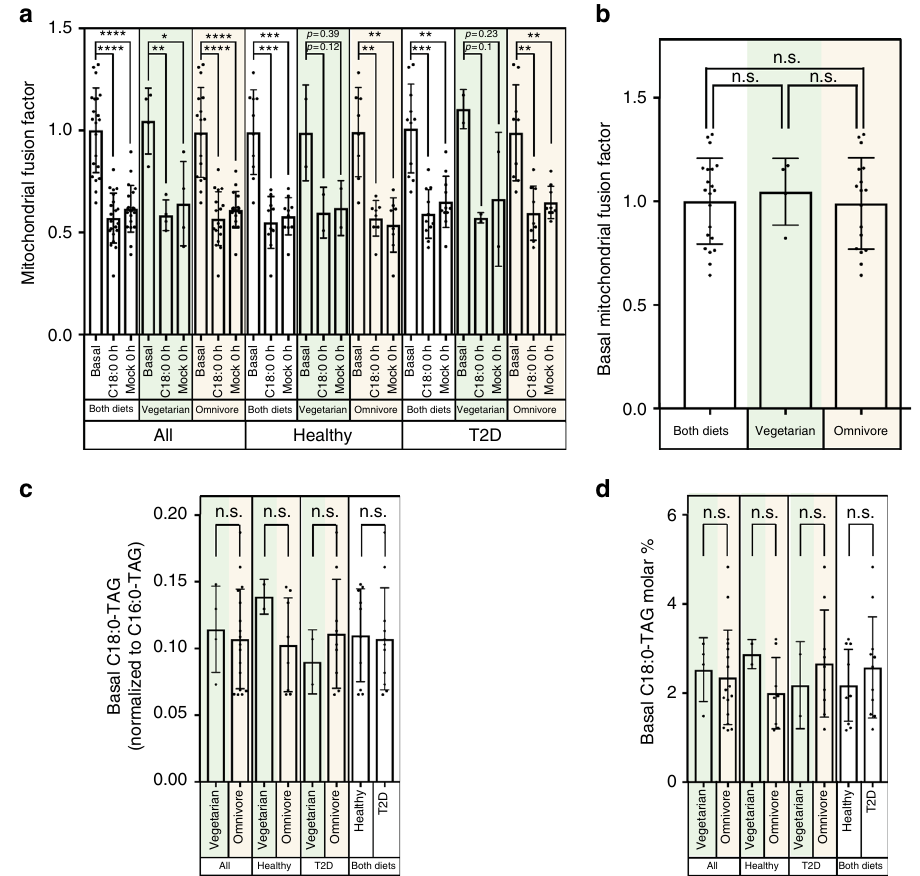
Fig. 4 Mitochondrial morphology is affected by short and medium-term, but not long-term, differences in dietary C18:0 intake. a Mitochondrial fusion drops after a 2-day low-C18:0 vegan diet in all categories of subjects (vegetarian, non-vegetarian, diabetic, healthy). b Basal mitochondrial fusion is similar in vegetarians and omnivores. ( n = 21 subjects total, of which eight healthy omnivores, two healthy vegetarians, nine type-2 diabetic omnivores, two type-2 diabetic vegetarians. Error bars = std. dev. * p ≤ 0.05, ** p < 0.01, *** p < 0.001, **** p < 0.0001 by t -test.) c , d “ Basal ” serum C18:0-TAG levels (at the beginning of the study, prior to the 2 day vegan diet) are not lower in vegetarians compared to omnivores. Note that all blood is drawn at 9:00 am after overnight fasting, which could mask dietary differences between vegetarians and omnivores. ( n = 21 subjects total, of which eight healthy omnivores, two healthy vegetarians, nine type-2 diabetic omnivores, two type-2 diabetic vegetarians. Error bars = std. dev. n.s. = not signi fi cant by t